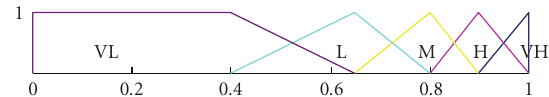
Figure 6: Membership functions for the fuzzy logic probability evaluators (VH: very high, H: high, M: medium, L: low, VL: very low). Table 3: Fuzzy associative memory matrix (FAM) for FLPE1. P1 (Probability of sub-event